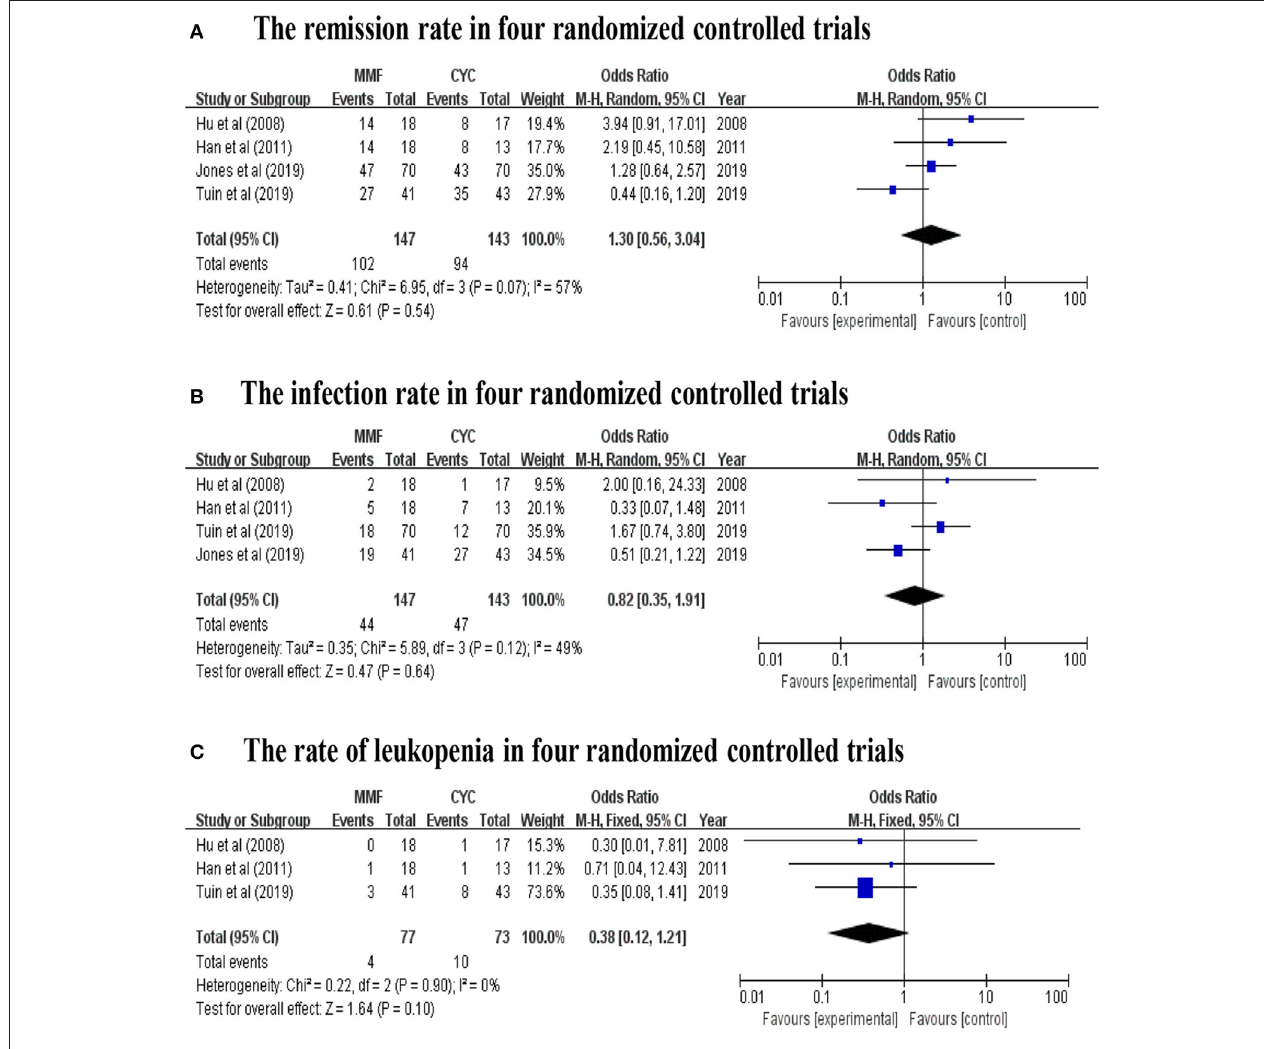
FIGURE 3 | (A) The remission rate, (B) the infection rate, and (C) the rate of leukopenia in four random controlled trials (By Review Manager 5.3).